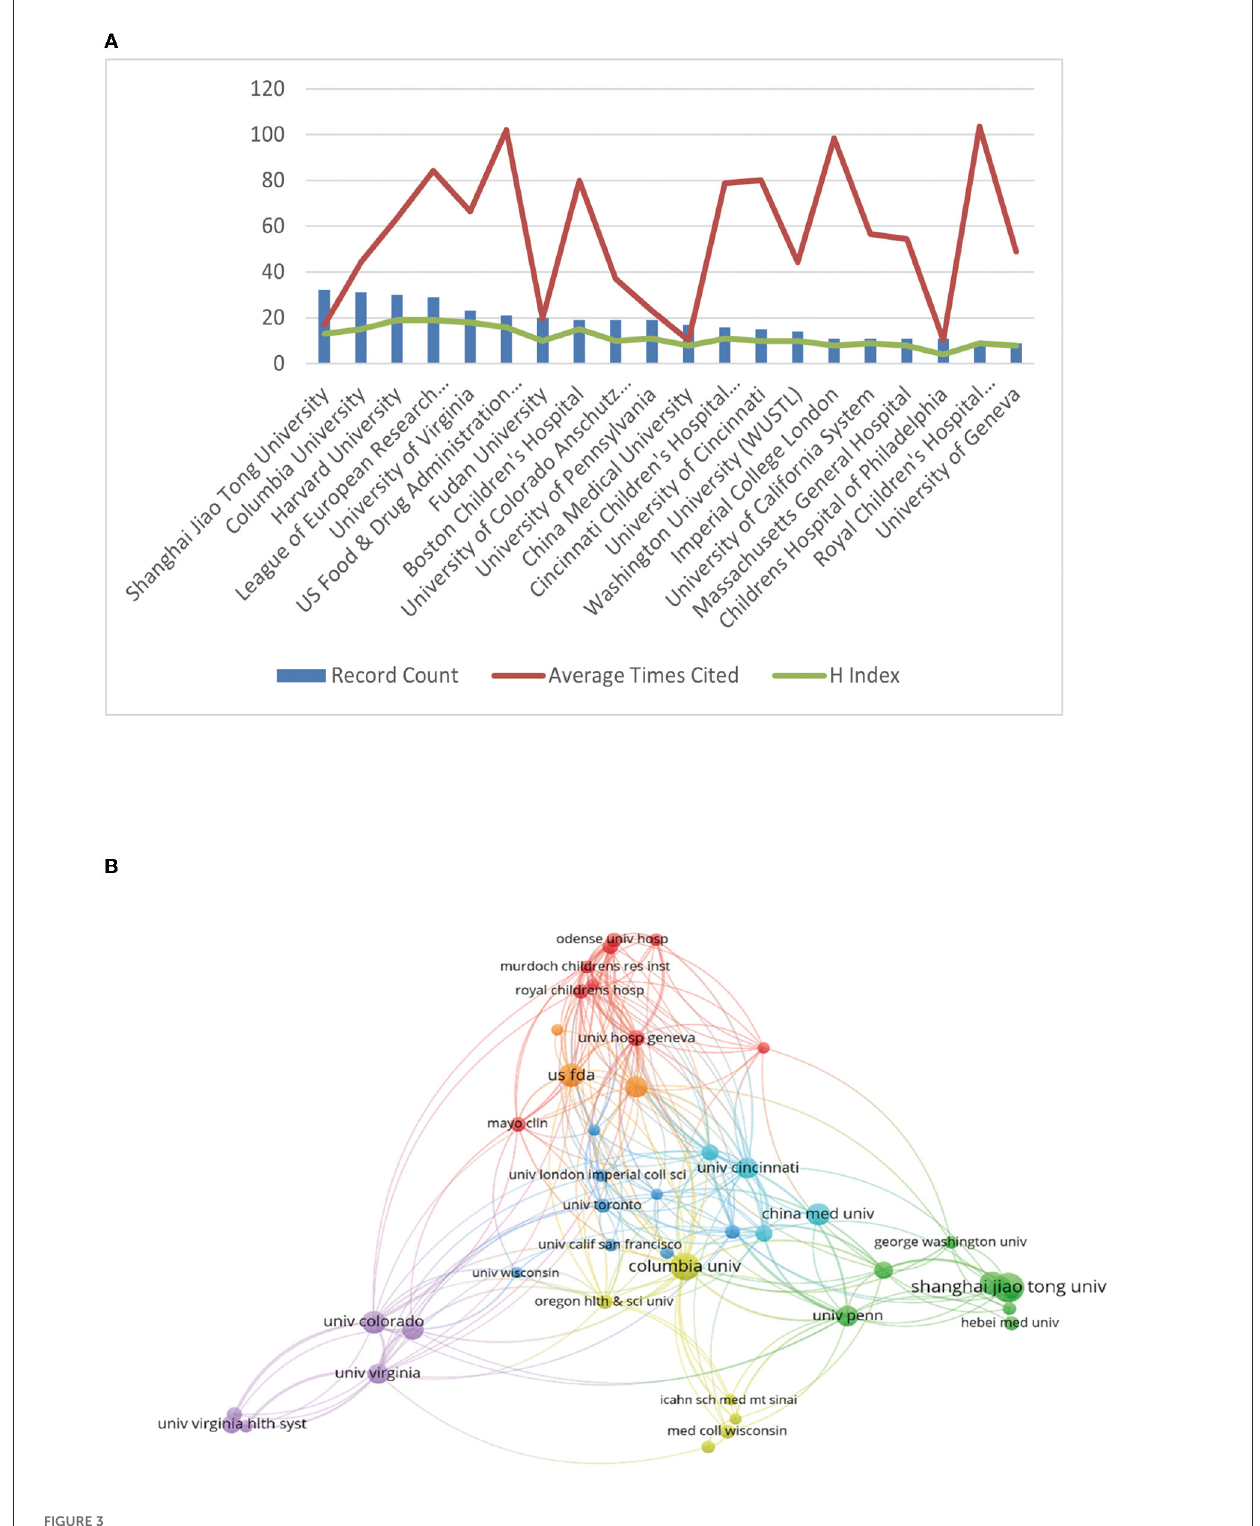
FIGURE3 The articles on the neurotoxicity of anesthesia in the developing brain published by different research institutions. (A) The top 20 institutions for productivity. The red line shows the typical number of citations per article, the green line shows the H-index of each institution, and the blue bar graph shows the number of articles published by each institution. (B) The network visualization map displaying institutional